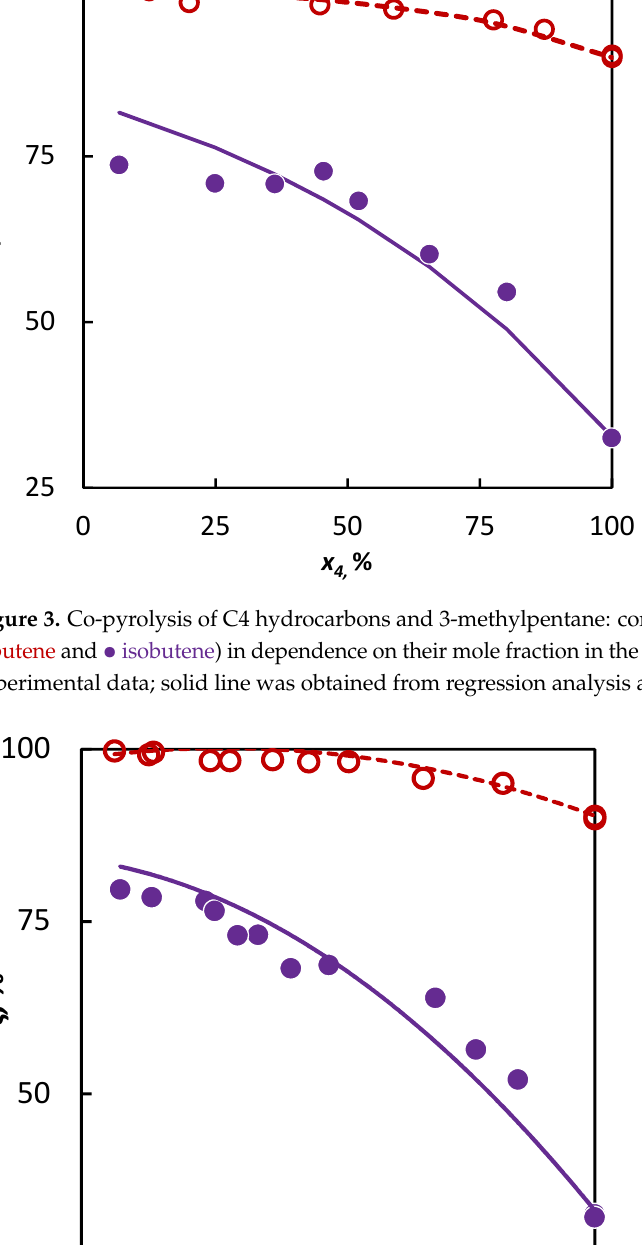
2-butene (cid:35)